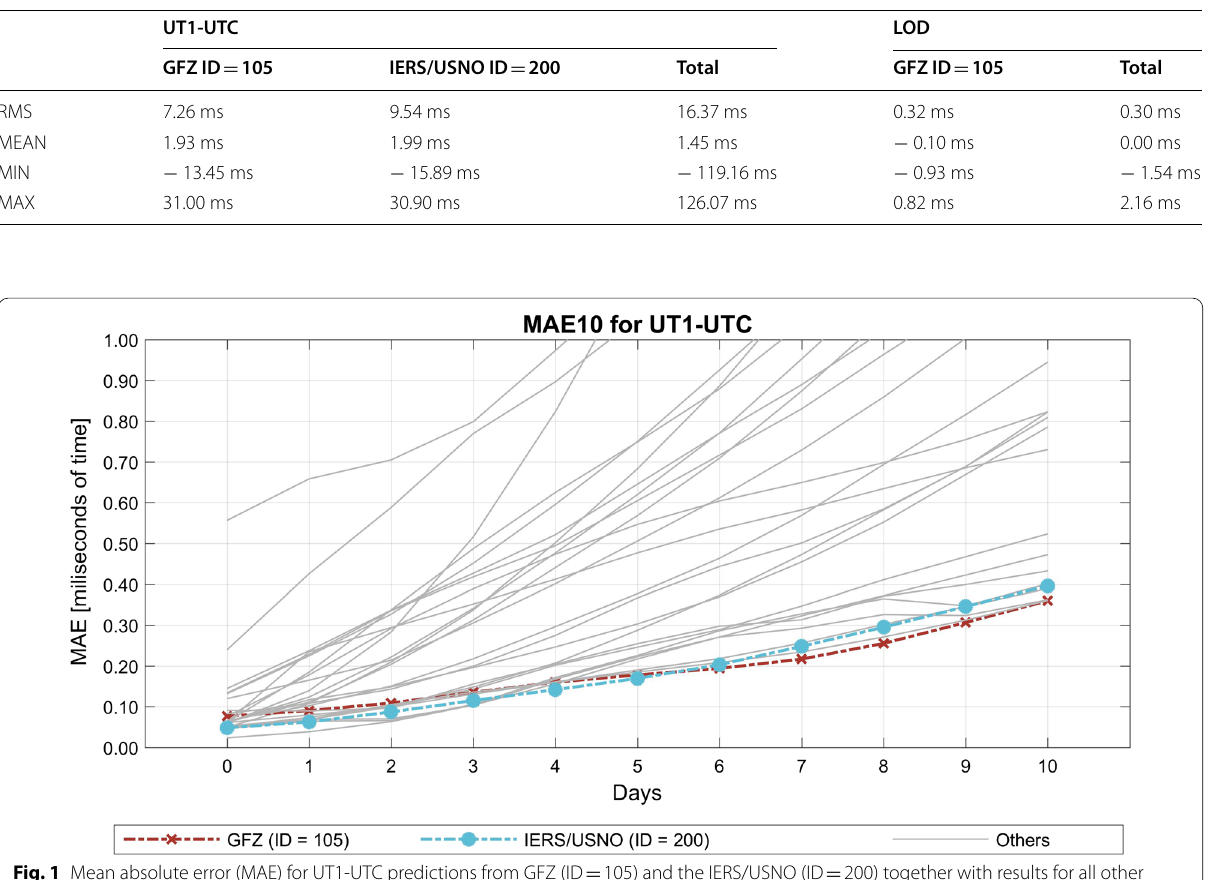
105) and the IERS/USNO (ID 200) together with results for all other = =